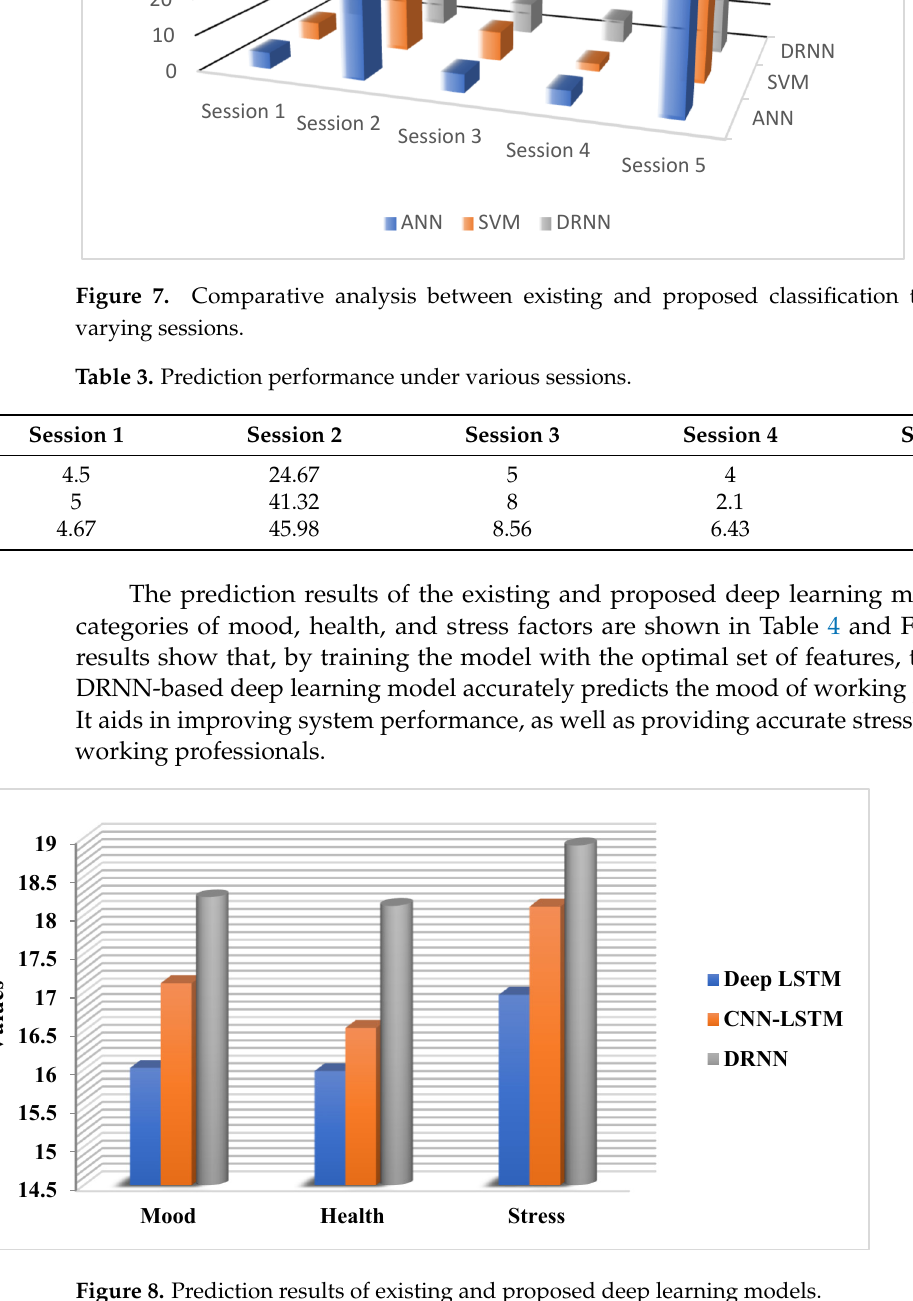
Figure 8. Prediction results of existing and proposed deep learning models.